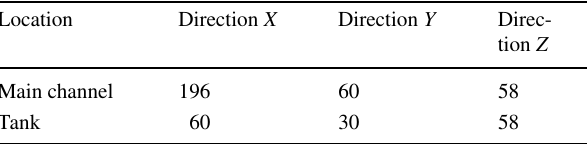
Table 1 Number of computational cells used in numerical simulation Location